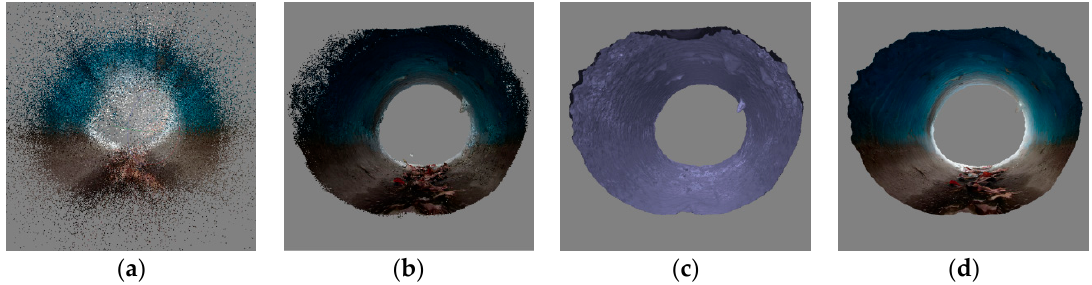
Figure 8. Reconstruction result of scene 2: sparse point cloud ( a ), dense point cloud ( b ), solid model ( c ), and textured model ( d ).